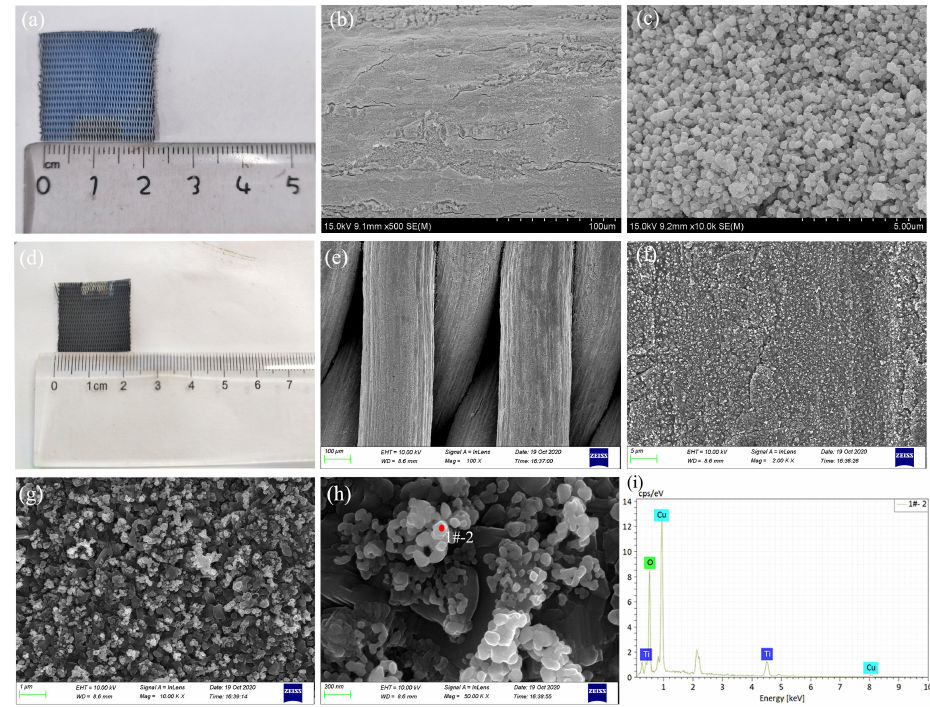
Figure 1. ( a ) Digital image of TiO 2 nanomeshes; ( b , c ) SEM images of TiO 2 nanomeshes at different magnification; ( d ) digital image of CuO-TiO 2 nanocomposites; ( e – h ) SEM images of CuO-TiO 2 nanocomposites at different magnification; ( i ) EDS spectrum of the typical region in Figure 1h.